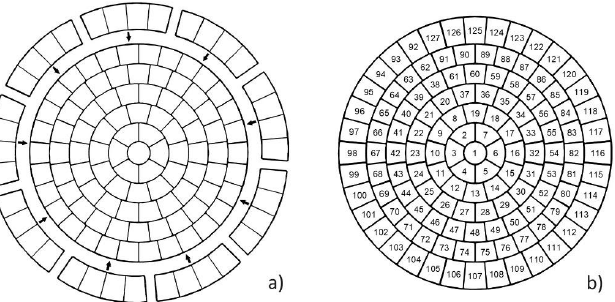
Figure 2. Configuration of DM electrodes: ( a ) piezoceramic plates and their arrangement; ( b ) the map of the control electrodes.